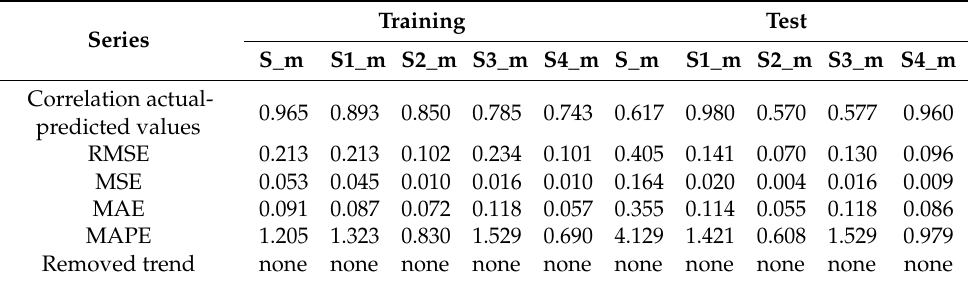
Table 3. Performances of the best models built for the monthly series with lag 1 variables as regressors. Series